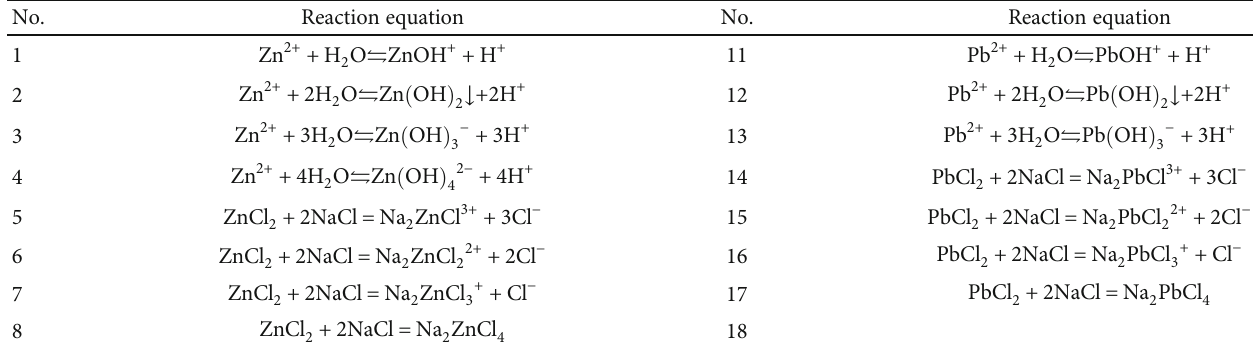
Table 1: Main chemical reactions of Pb and Zn in the NaCl solution.